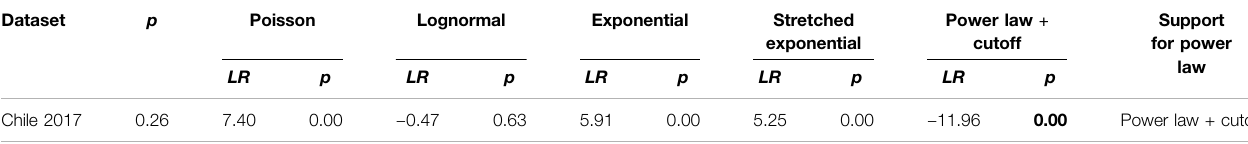
TABLE 4 | Results of the comparison of the power law with alternative distributions. Dataset